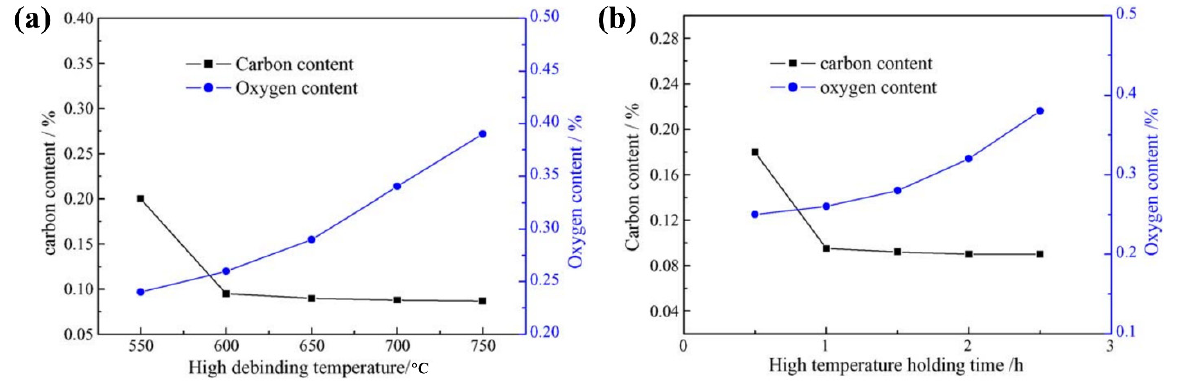
Figure 10. C and O uptake during debinding as a function of ( a ) debinding temperature and ( b ) sintering (holding) time during debinding of Ti-6Al-4V MIM (Reprinted with permission from [179]. Copyright 2006, Journal of Materials Processing Technology, Elsevier).